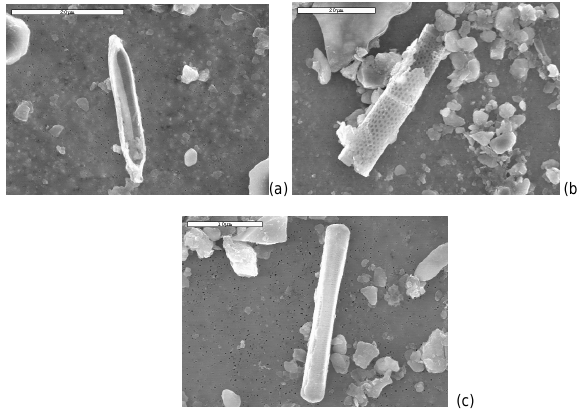
Figure 5: SEM images of aerosols found on the rainwater filters: Illustration of the Bodélé diatoms Fig. 5. SEM images of aerosols found on the rainwater filters: illus- presence in the R3B4 samples originating from MCS developed in the North of Niger (a) and in the tration of the Bod´el´e diatoms presence in the R3B4 samples orig- R7B5 samples colleted during SLMCS developed in the South of Niger (b, c). inating from MCS developed in the North of Niger (a) and in the R7B5 samples colleted during SLMCS developed in the South of Niger (b, c)